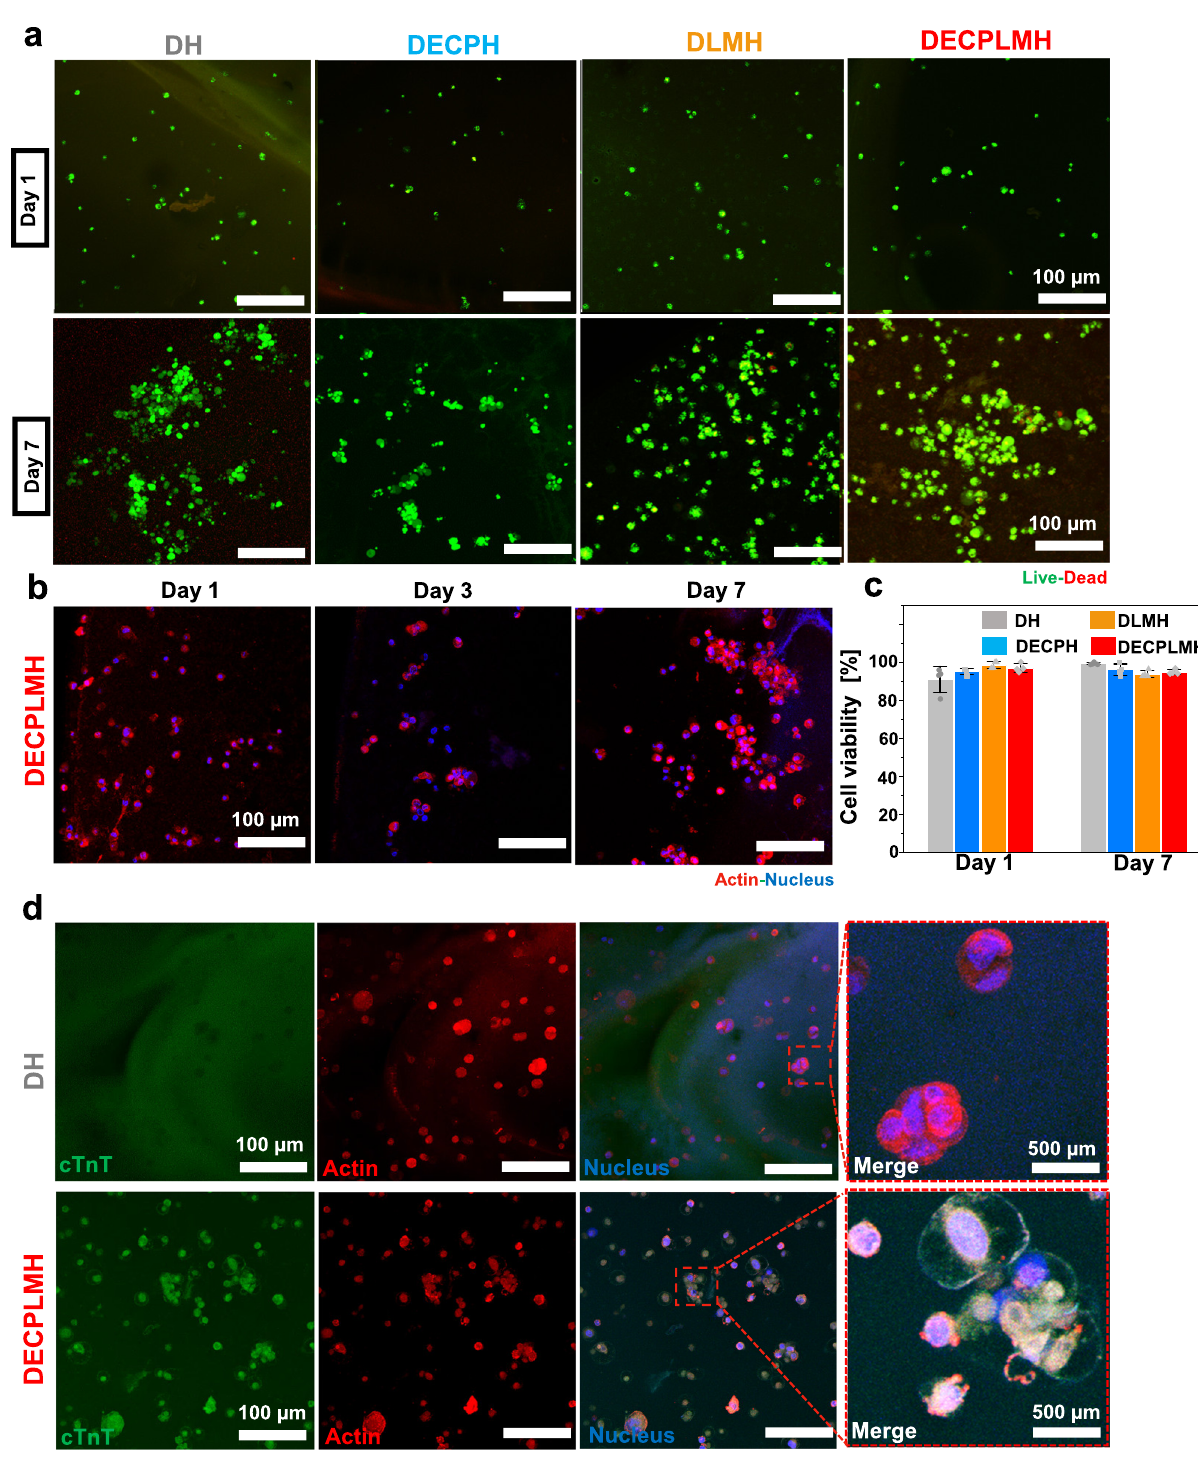
Fig. 7 Biocompatibility of the electroconductive hydrogels in vitro. a Live-dead staining of mouse myoblasts cultured in hydrogels at day 1 and day 7, with calcein-AM (green; viable) and ethidium homodimer-1 (red; dead). Scale bar: 100 μ m. A representative image of three biological replicates is shown. b Immuno fl uorescence staining of the cells cultured in DECPLMH at day 1, day 3, and day 7 of the cell nucleus (blue; Hoechst) and actin (red; phalloidin). Scale bar: 100 μ m. A representative image of three biological replicates is shown. c The cell viability of the C2C12 cells after 3D culture at day 1 and day 7 ( n = 3 biologically independent samples, mean ± SD). d cTnT (green) and actin (red) immuno fl uorescence staining of C2C12 cells cultured in DH and DECPLMH hydrogels with differentiation medium for 10 days. A representative image of three biological replicates is